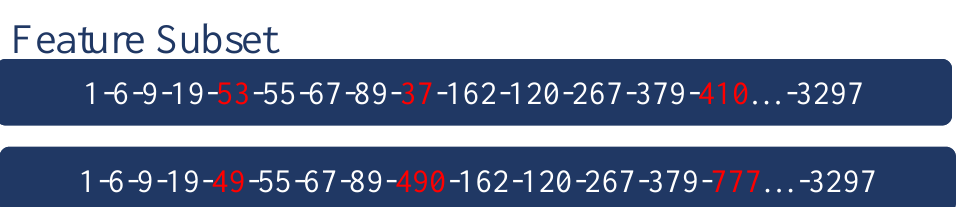
Figure 3. Genetic Operator: ( a ). Schematic diagram of the cross operation. Two individuals generate offspring by exchanging the parts before and after the Crossover Point. ( b ). Specific calculation flow chart of the fitness function.